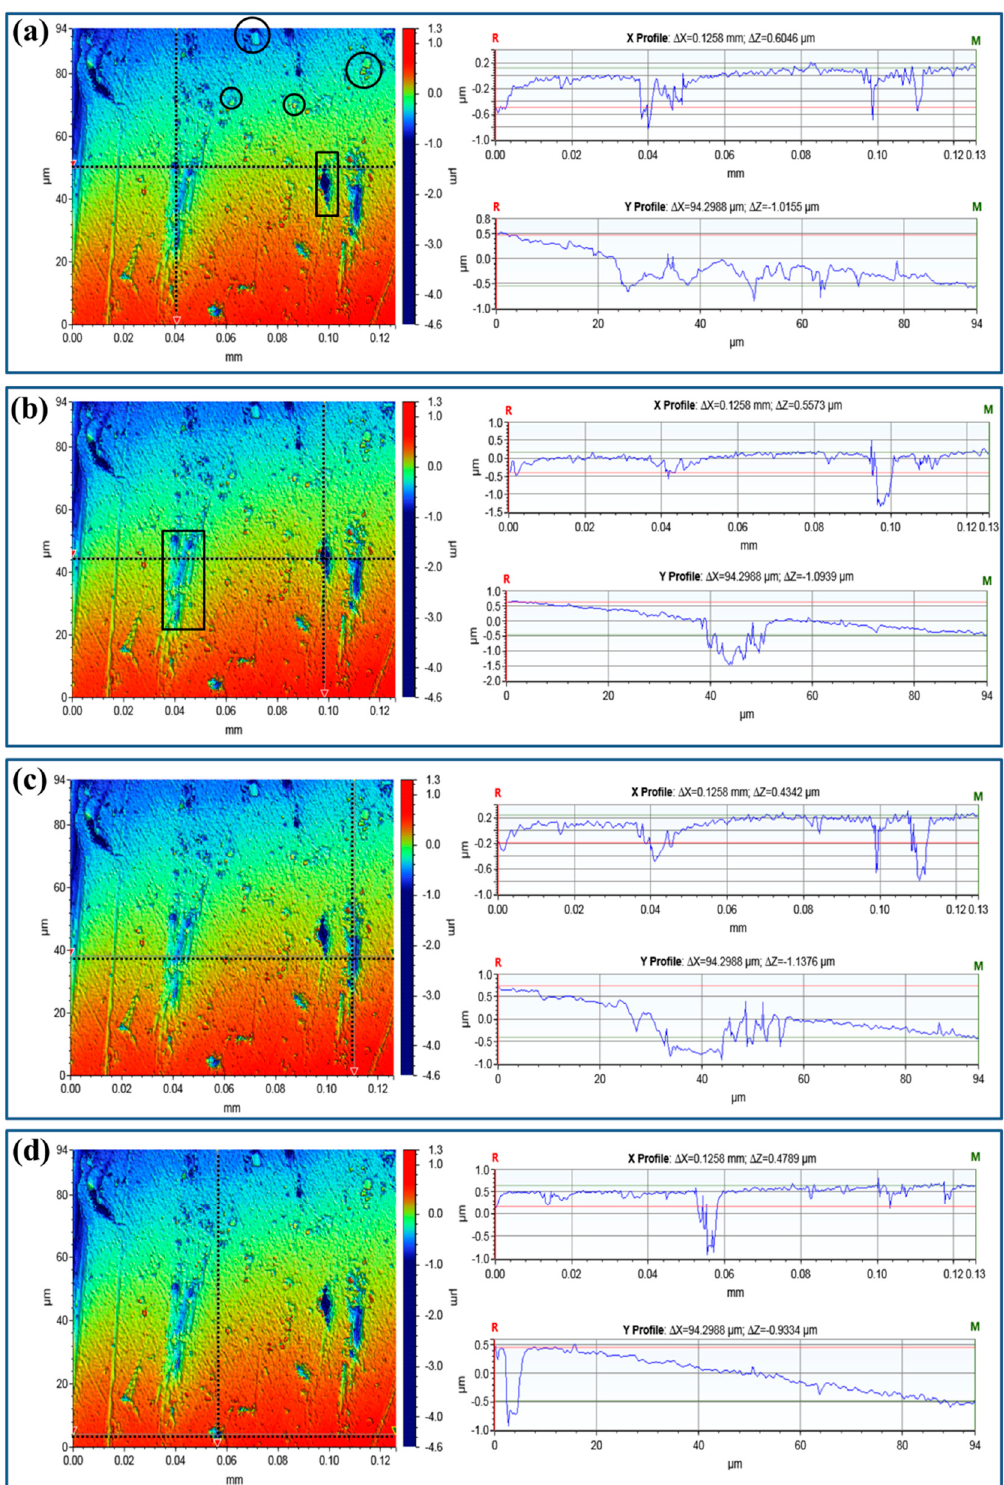
Figure 6. Three-dimensional optical profilometry images of Sample-H after constant immersion for 240 h in 3.5 wt % NaCl together with the line profiles of the pits. The black circles highlight the peripheral dissolution/trenching of the Al matrix around the cathodic precipitates, while rectangles show the classical channeling corrosion merging pits. ( a – d ) highlight the line profiles crossing the selected pit, which are identified these black dot lines.